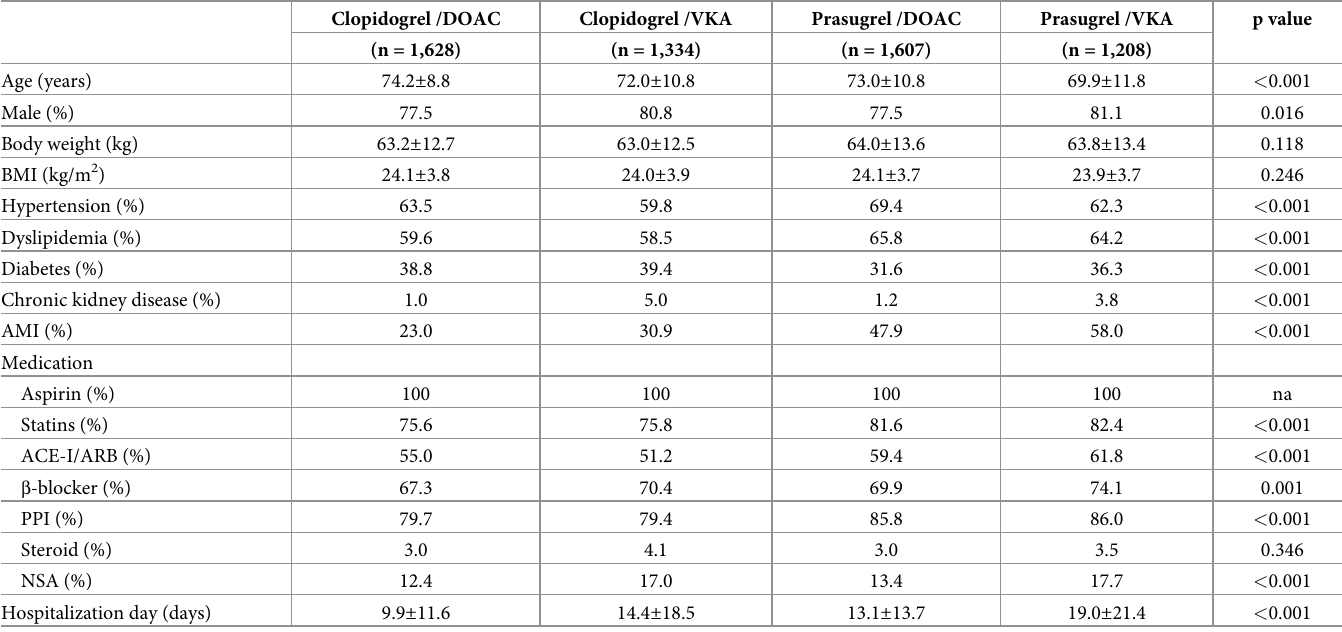
Table 1. Baseline clinical characteristics.